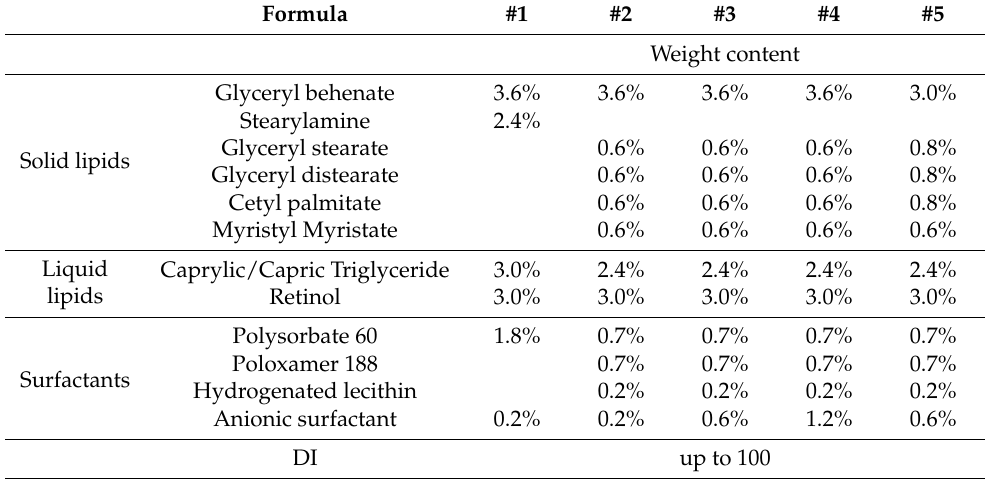
Table 1. Compositions of retinol-loaded vacuum-assisted lipid nanocarriers